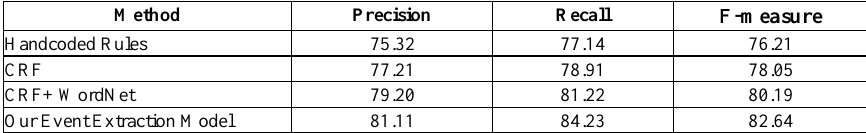
Table 1. Results for Event Extractin MUC DataExample table